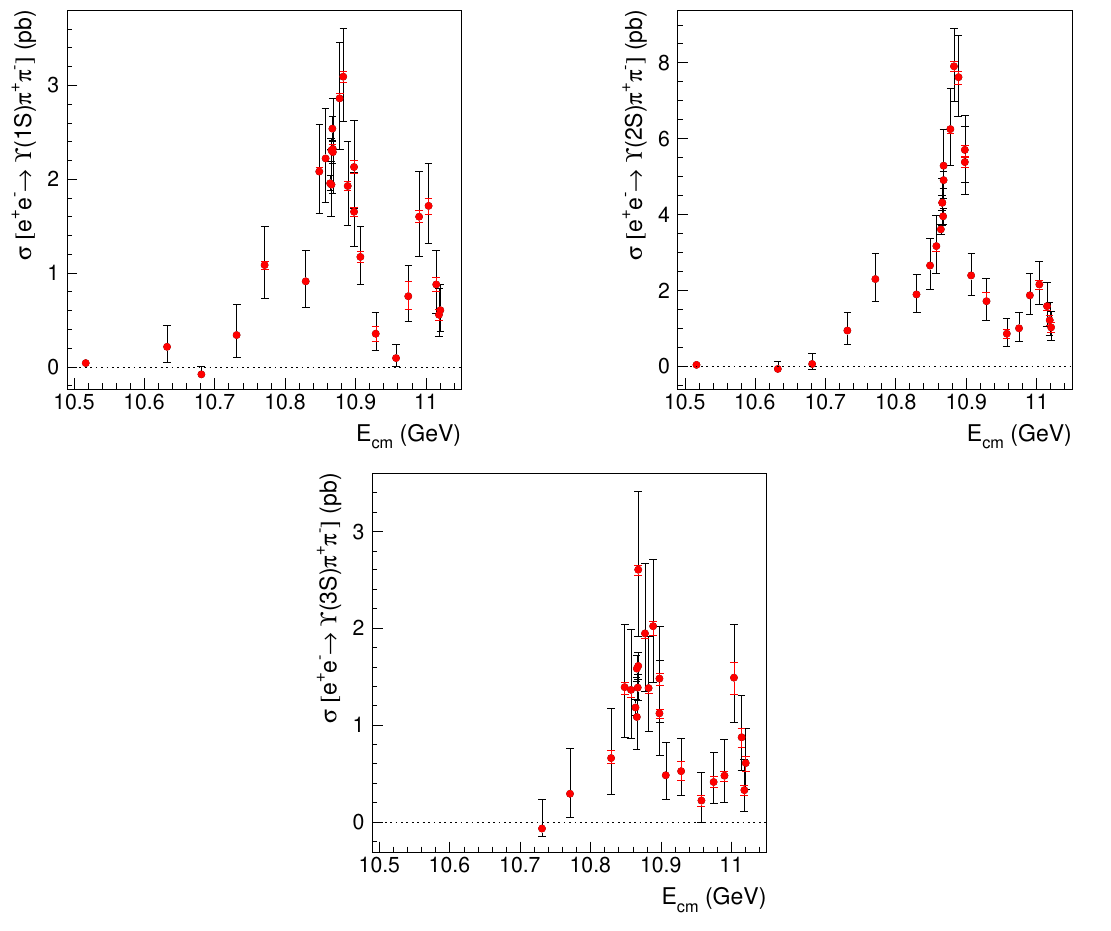
Figure 6 . Born cross sections for e + e (cid:0) ! (cid:7)( nS ) (cid:25) + (cid:25) (cid:0) ( n = 1 ; 2 ; 3) with statistical (black) and uncorrelated systematic (red) uncertainties, measured for di(cid:11)erent c.m.